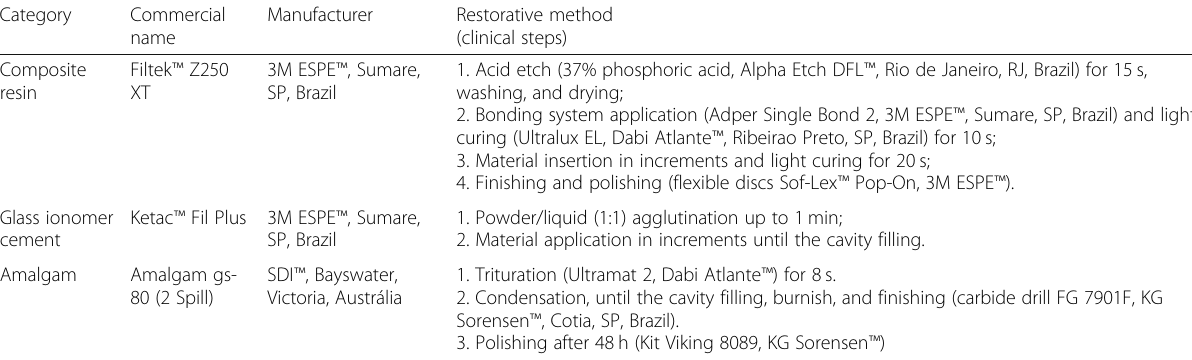
Table 1 Used material, commercial brands, manufacturers, and restorative